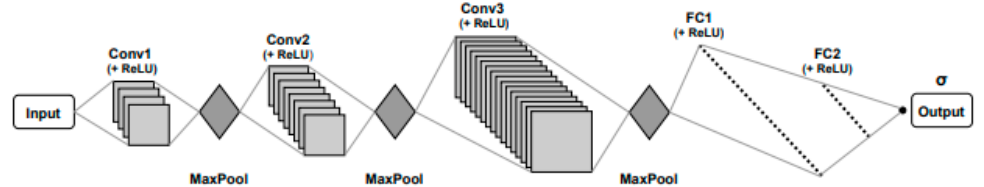
Figure 21. Fundamental structure of a CNN model.